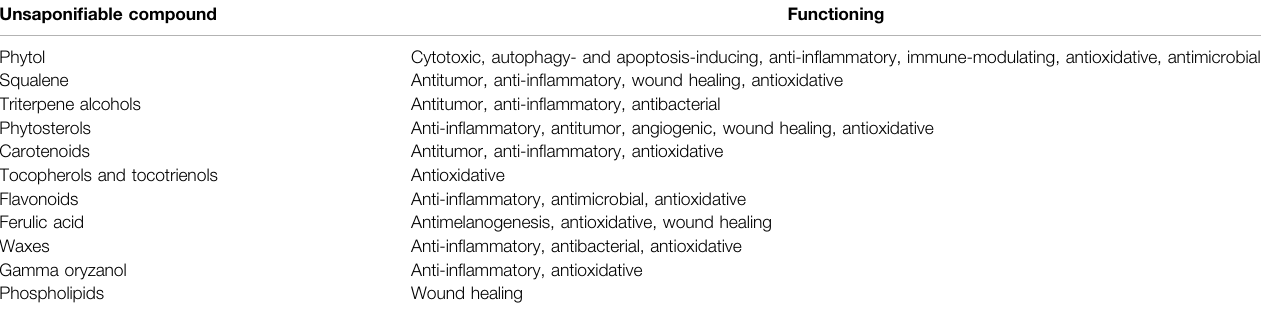
TABLE 3 | Dermal activities of selected unsaponi fi able compounds; adopted from (Polj š ak and Ko č evar Glava č , 2021). Unsaponi fi able